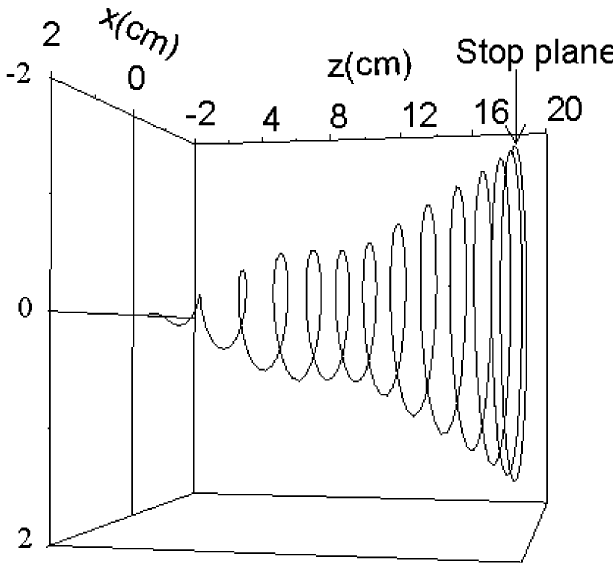
FIG. 5. Dependence of the phase difference ’ on the longitu- dinal coordinate z : (A) r (cid:1) 1 : 5 cm (C) r 0